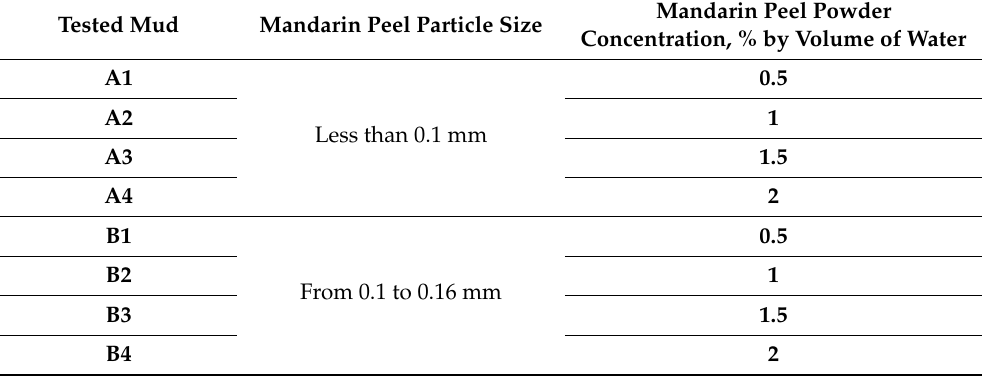
Table 2. Composition of tested drilling-mud samples which contain MPP. Tested